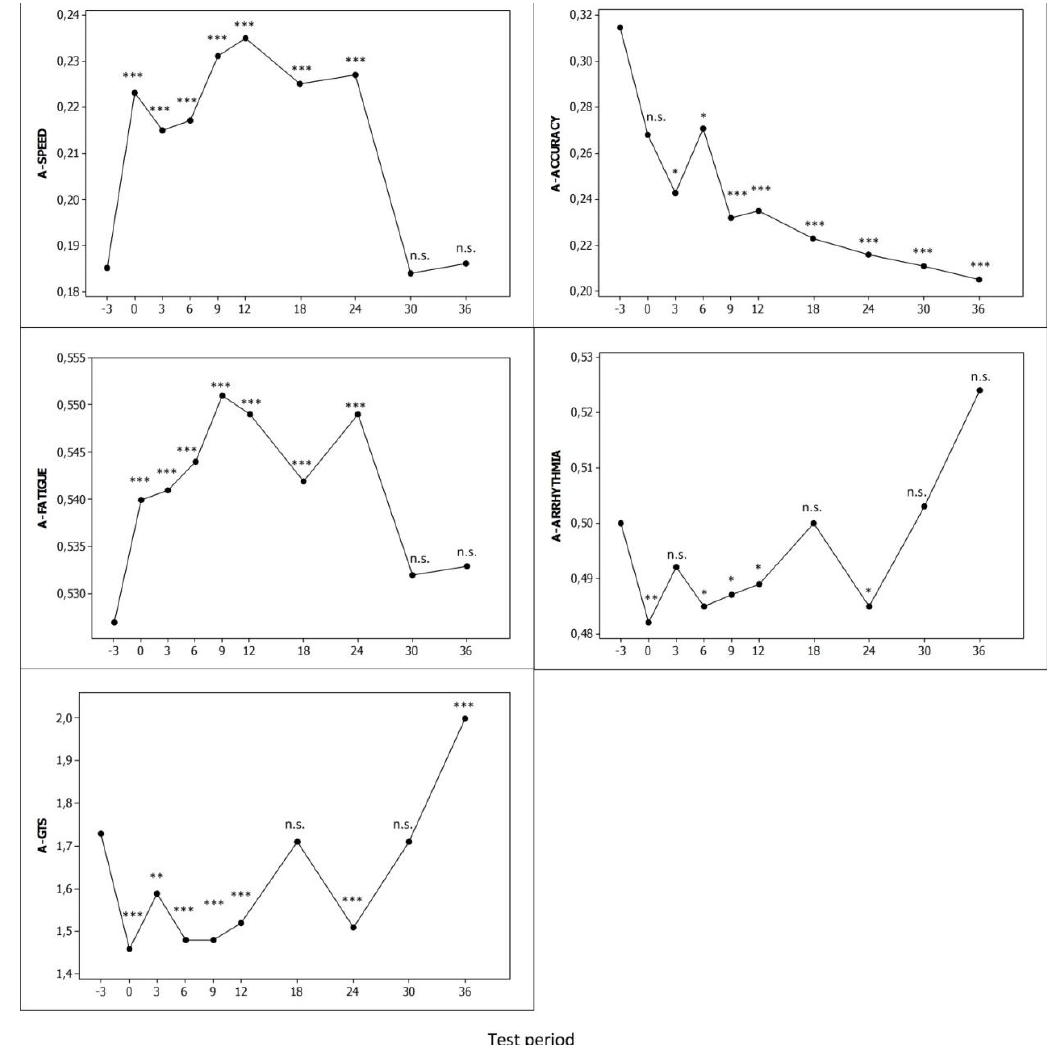
Figure 5. Trends of mean computed scores of LCIG-naïve patients over the 36-months study period, corrected for individual subject variation using linear mixed-effects